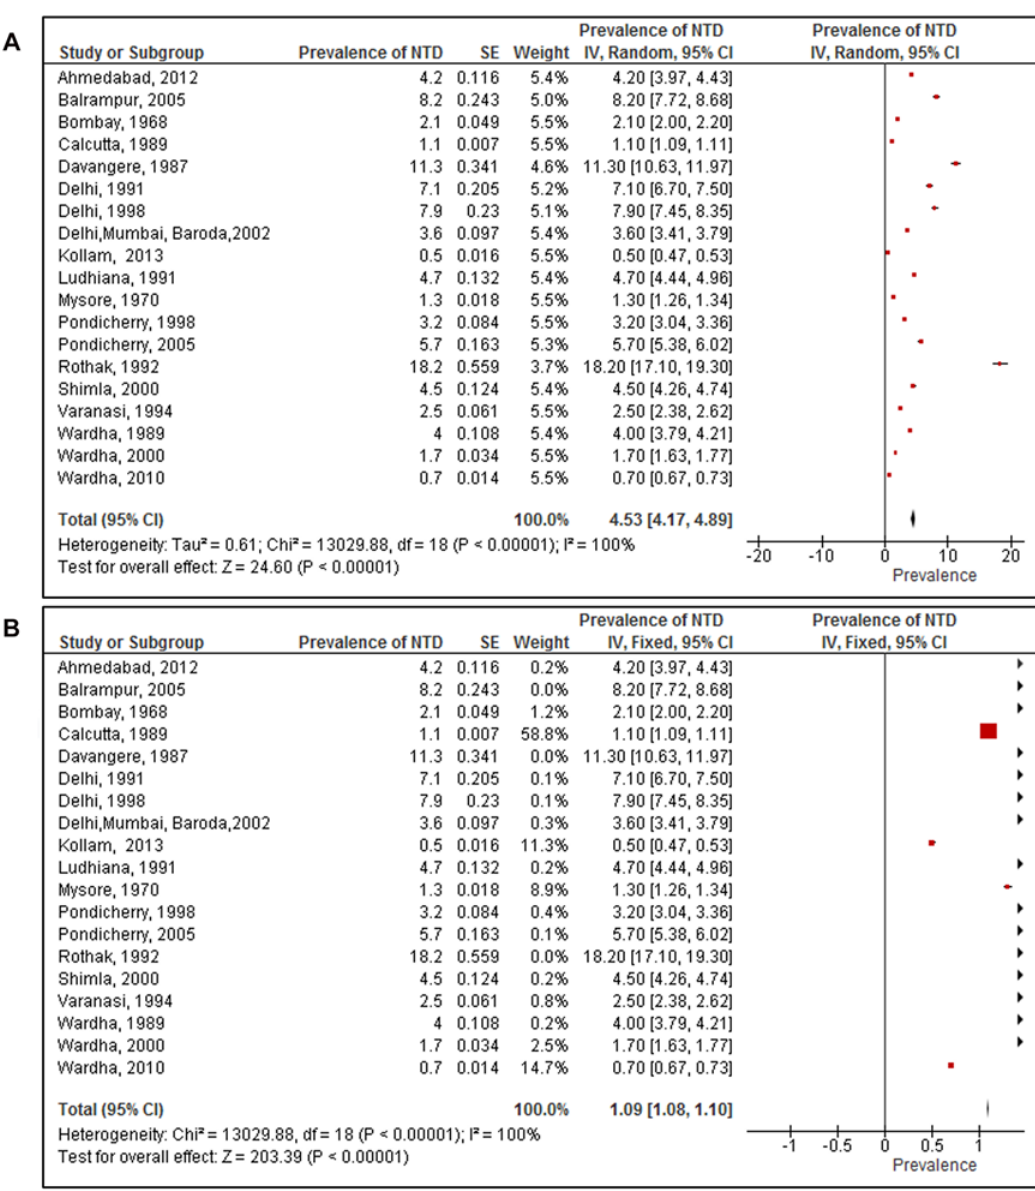
PLOS ONE | DOI:10.1371/journal.pone.0118961 March 13,